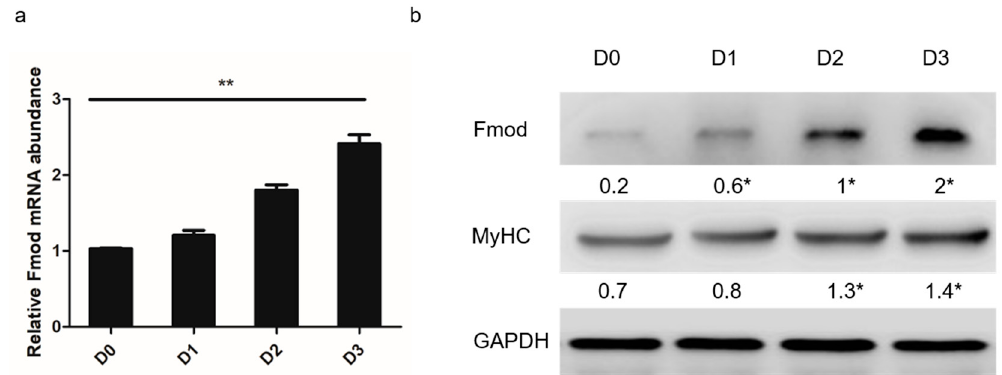
Figure 1. Expression of the fibromodulin (Fmod) gene in chicken primary myoblast di ff erentiation into myotubes. ( a ) The expression levels of Fmod mRNA at 0, 24, 48, and 72 h in di ff erentiation medium. ( b ) Western blot analysis of Fmod and MyHC protein levels at 0, 24, 48, and 72 h in di ff erentiation medium. Note: * p < 0.05, ** p < 0.01 versus “D0”.